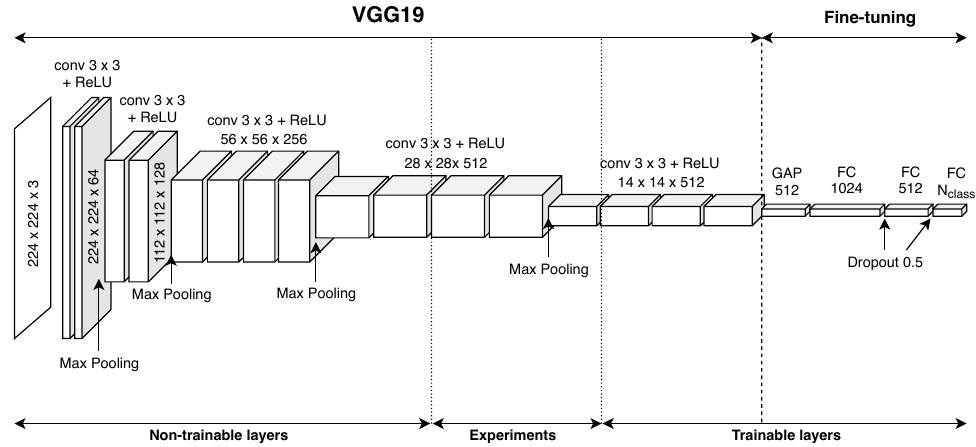
Figure 6. Network architecture used for logo detection. On top of the figure, which layers have been kept from the VGG19 architecture and which ones were added in the fine-tuning re-training phase are indicated. In such a second training, some layers are frozen, thus maintaining the ImageNet weights, and others are not. On bottom of the figure, frozen and trainable layers are specified. The decision of training or not some of these layers was made at experimental time (see Section